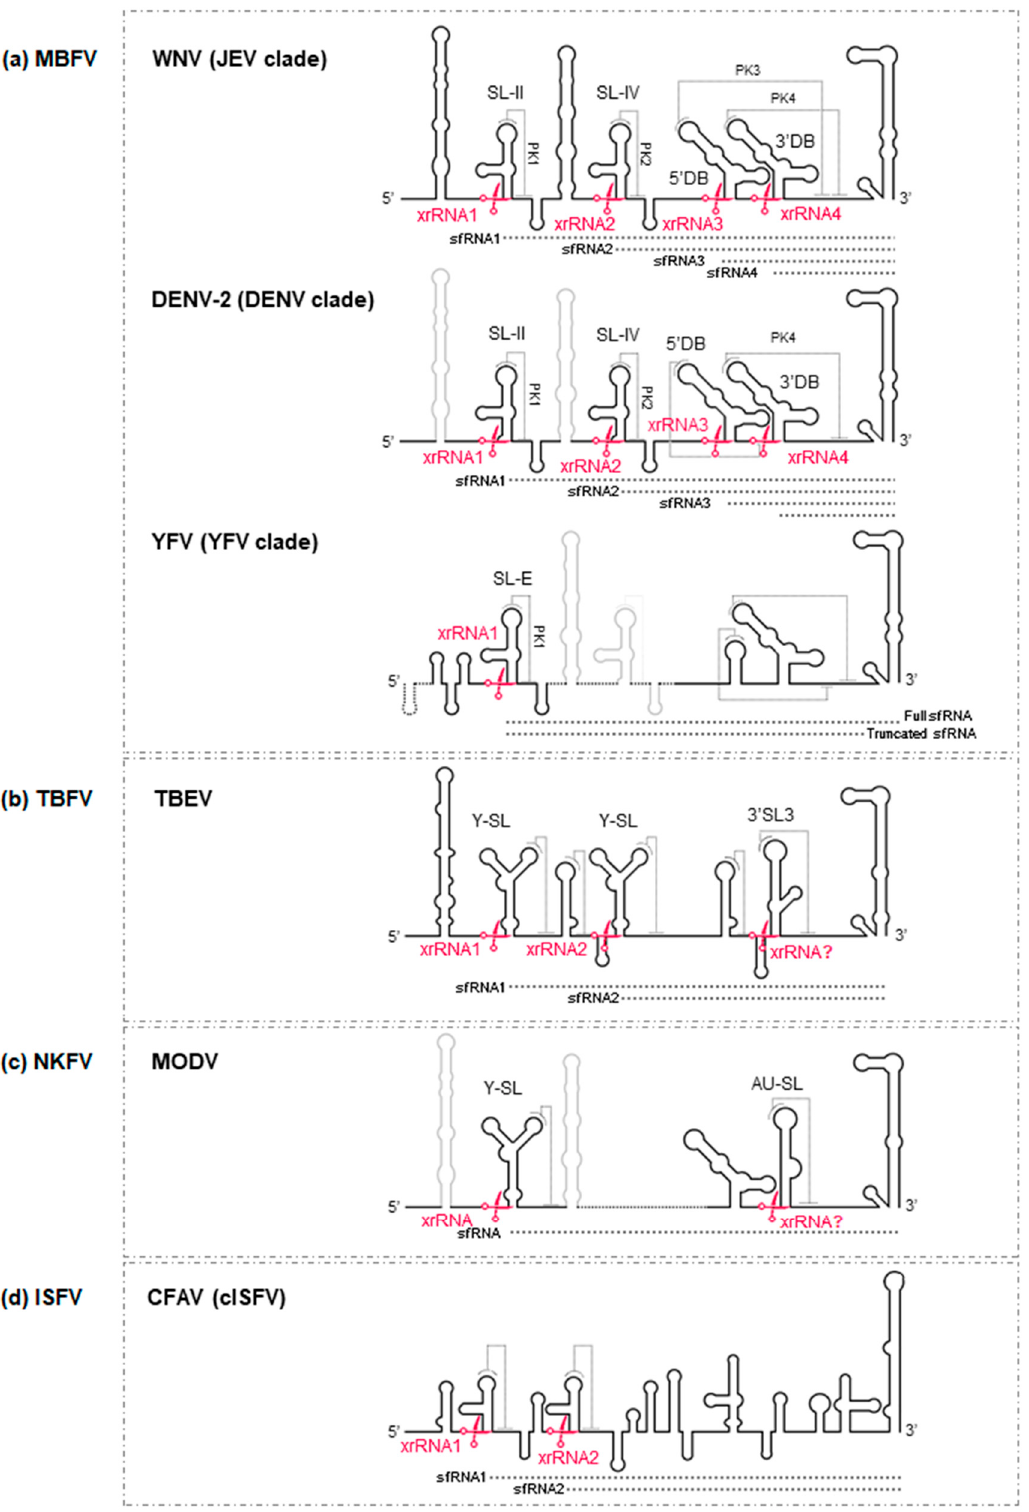
Figure 4. sfRNAs pattern. Diagram of the proposed xrRNA within the 3 ′ UTR of the RNA genome of representative flaviviruses of: ( a ) the MFV; ( b ) TBFV; ( c ) NKFV and ( d ) ISFV groups. xrRNA elements are indicated by red scissors. xrRNA? denotes that the corresponding putative sfRNA has not been identified. sfRNAs are represented by dotted black lines. The key for the lines is as described for Figure 2.